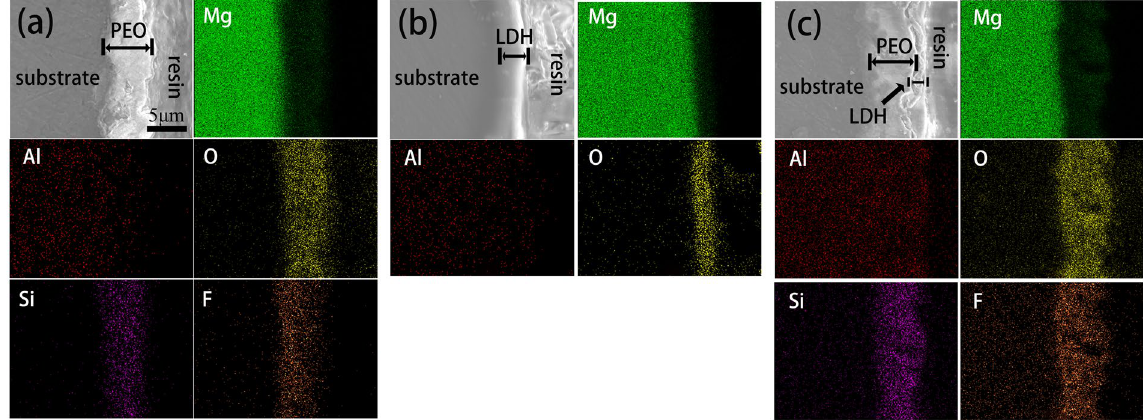
Figure 5. Cross-sectional morphology of PEO ( a ), LDH ( b ) and PEO/LDH ( c ), and corresponding scanning maps of characteristic elements.